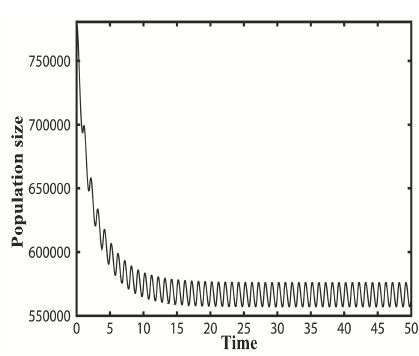
= 0 at q = 4 Figure 3. harvesting e ff ect at dp dt in model 2 Figure 4. Fish population dynamics for q = 4 in model 2